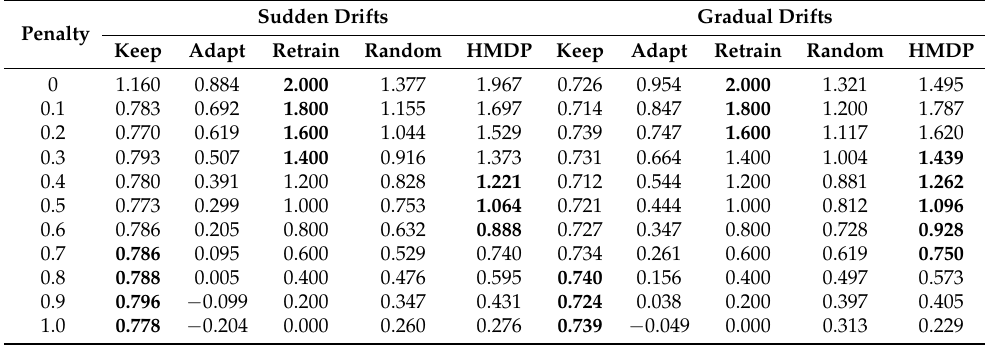
Table 2. The average reward of the 18 sudden and gradual transition drifts. Penalty